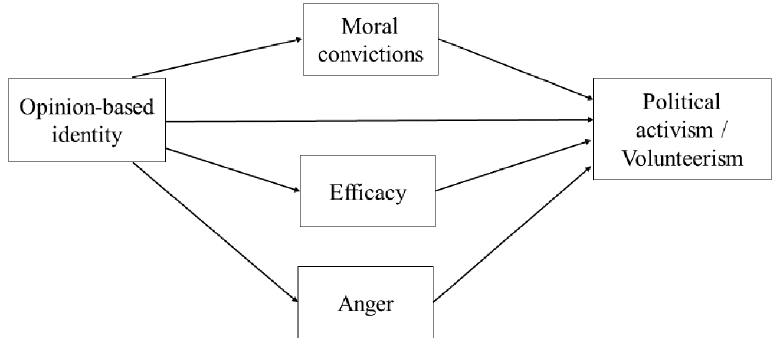
Figure 1. Predicted mediation of moral convictions, group based anger and efficacy beliefs in the effect of opinion-based identity on both volunteerism and political